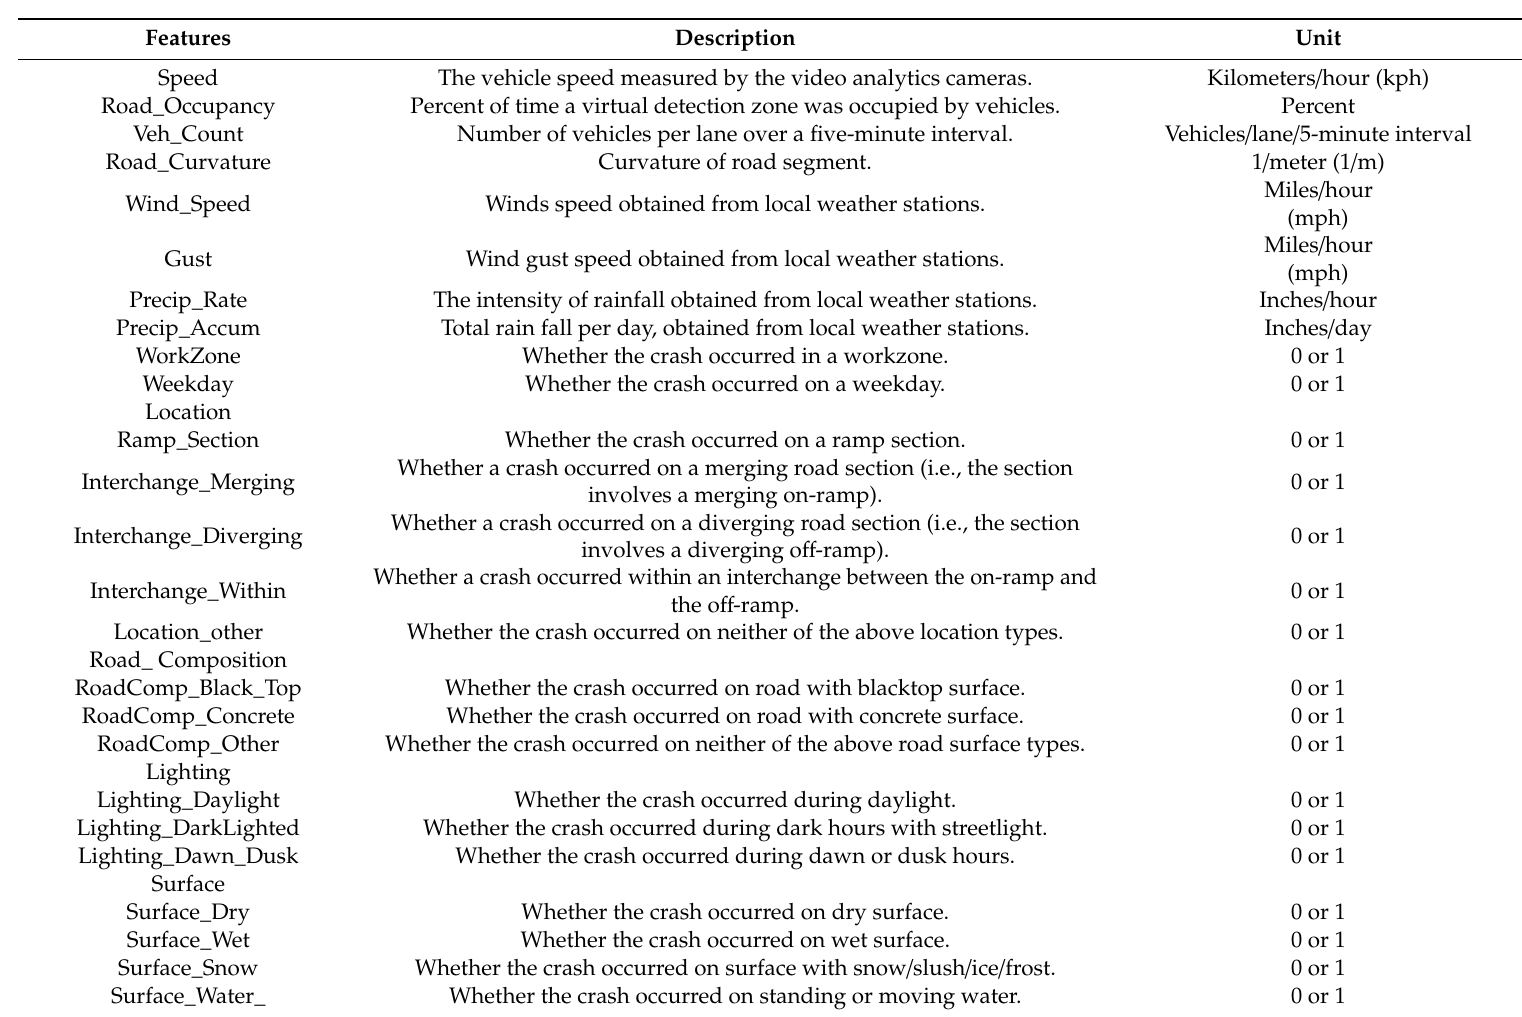
Table 1. Roadway, tra ffi c, weather, and environmental (RTWE)feature